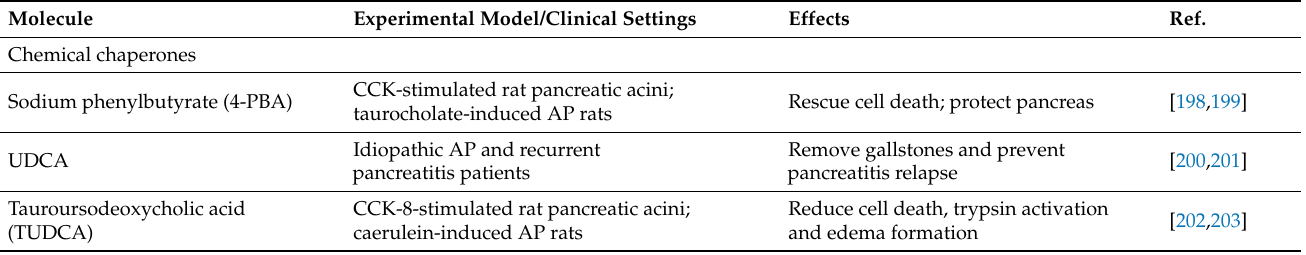
Table 1. Candidate small molecules targeting ER stress for the treatment of alcohol-related pancreatitis. Molecule Experimental Model/Clinical Settings Effects